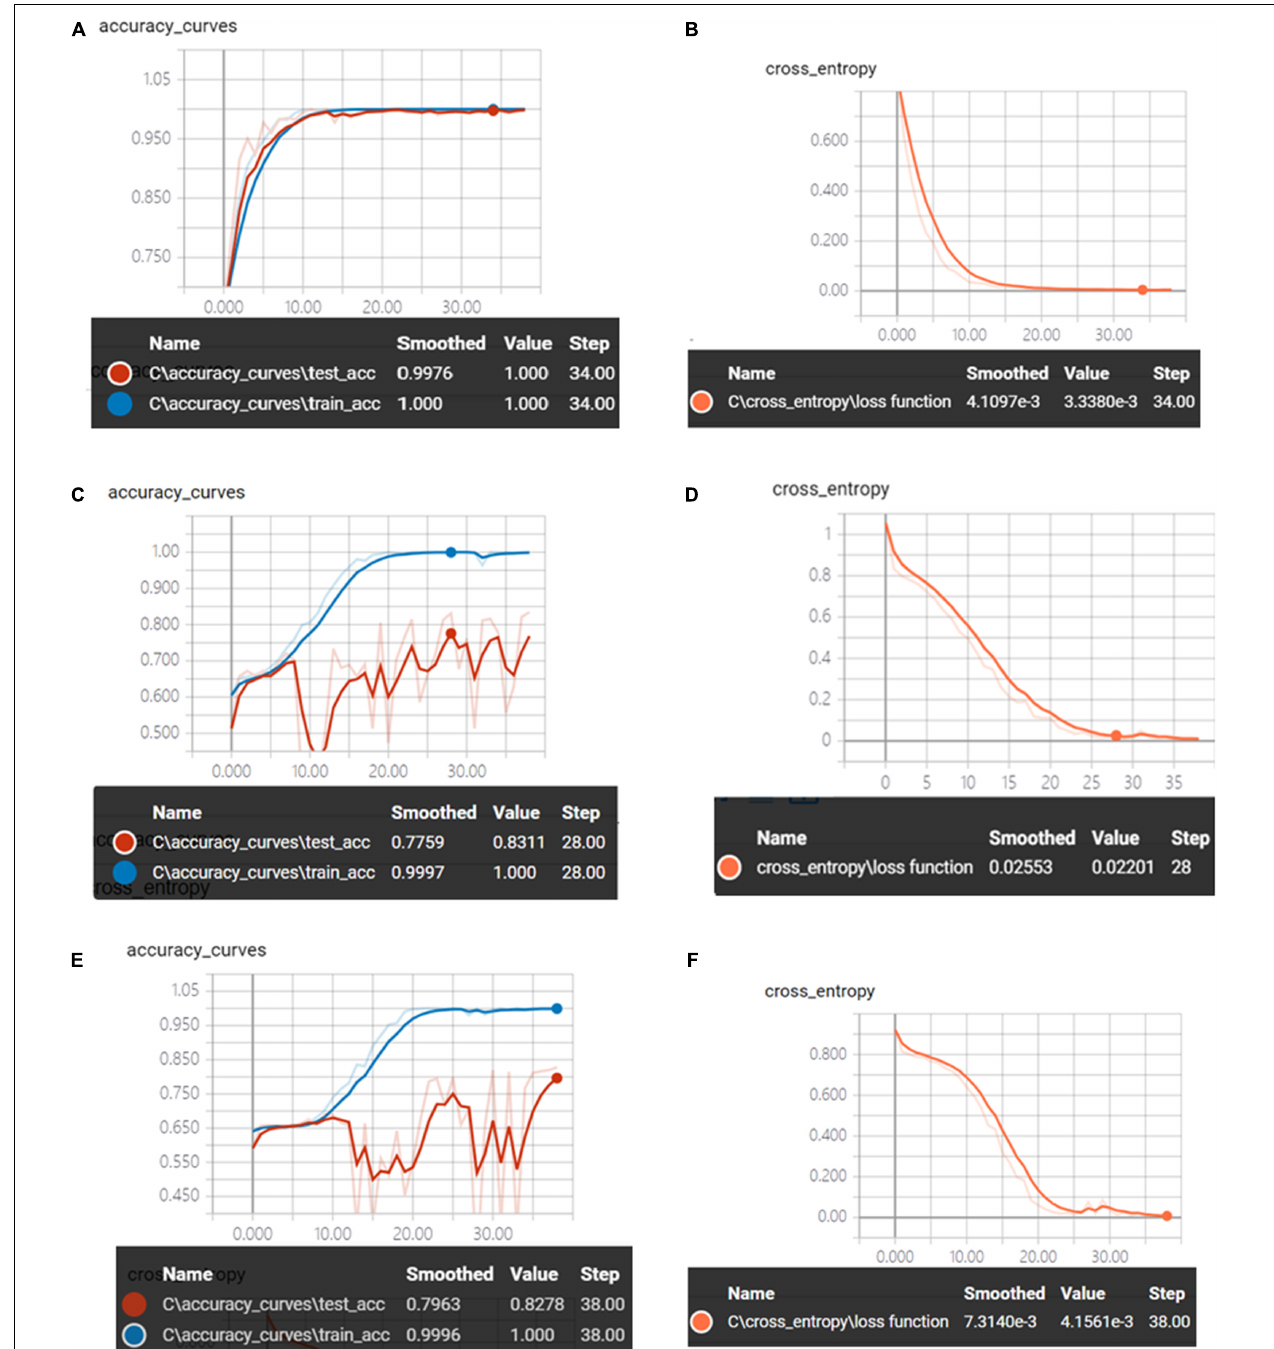
FIGURE 6 | (A) The accuracy curves of synchronous 2DCOS spectra on the 1,750–400-cm − 1 band. (B) The cross-entropy cost function of synchronous 2DCOS spectra on the 1,750–400-cm − 1 band. (C) The accuracy curves of asynchronous 2DCOS spectra on the 1,750–400-cm − 1 band. (D) The cross-entropy cost function of asynchronous 2DCOS spectra on the 1,750–400-cm − 1 band. (E) The accuracy curves of i2DCOS spectra on the 1,750–400-cm − 1 band. (F) The cross-entropy cost function of i2DCOS spectra on the 1,750–400-cm − 1 band.